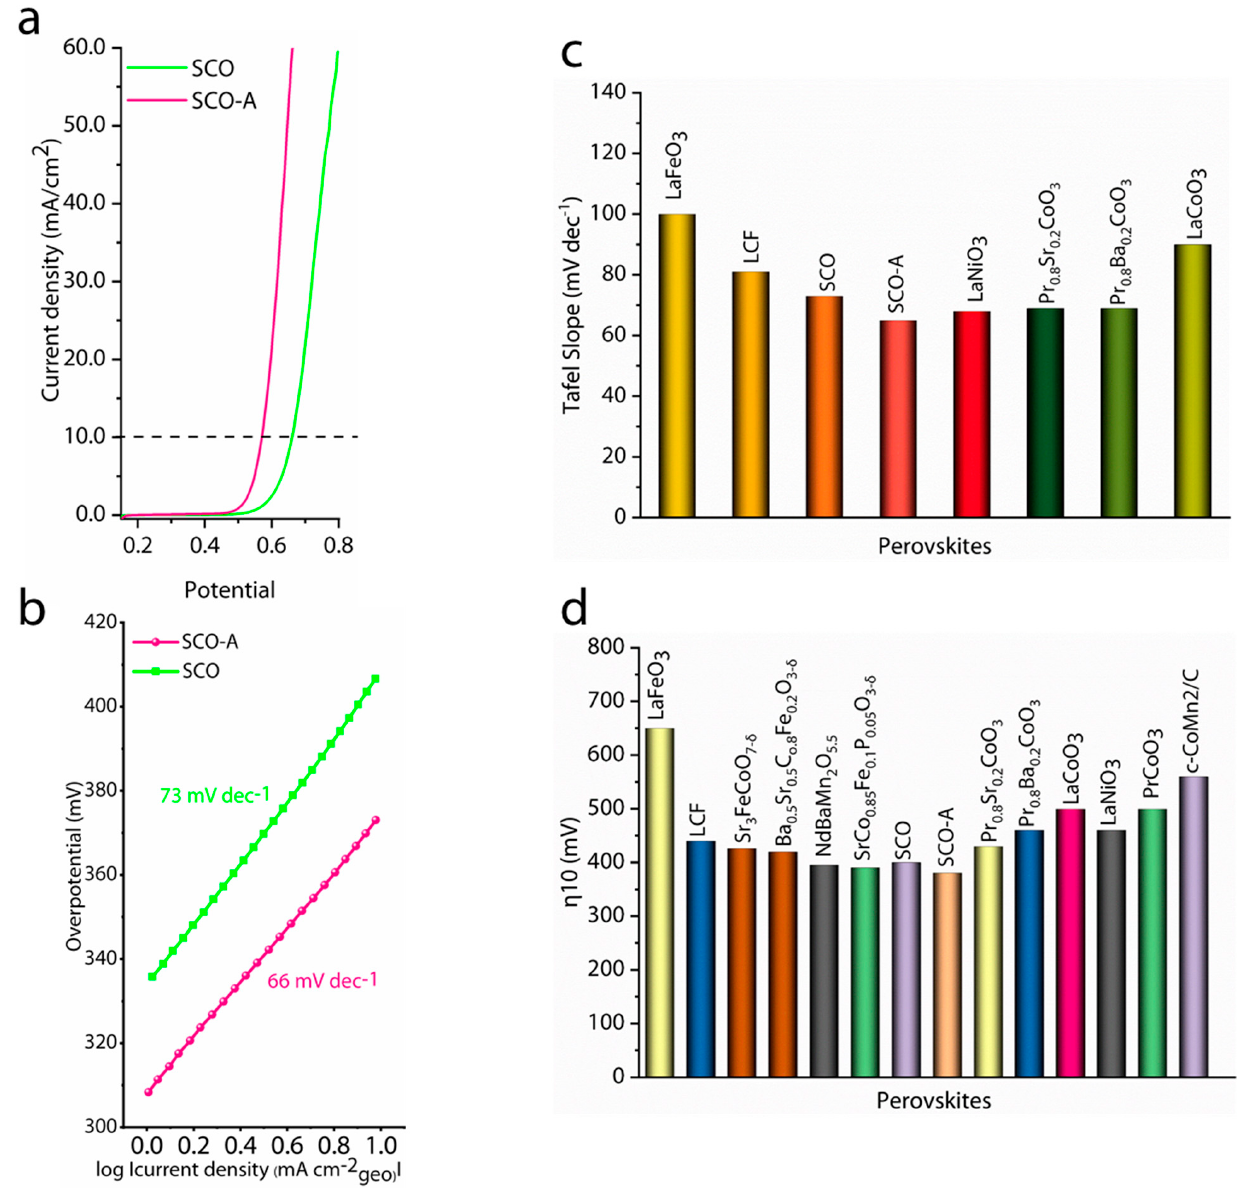
Figure 2. Electrocatalytic performances. ( a ) LSV polarization curve to demonstrate OER kinetic currents for SCO and SCO-A obtained in an O 2 -saturated 1M KOH environment. ( b ) Tafel plots. ( c ) A comparison of the Tafel plots for various electrodes. ( d ) Overpotential for different cathodes at the standard current density of 10 mA cm − 2 .